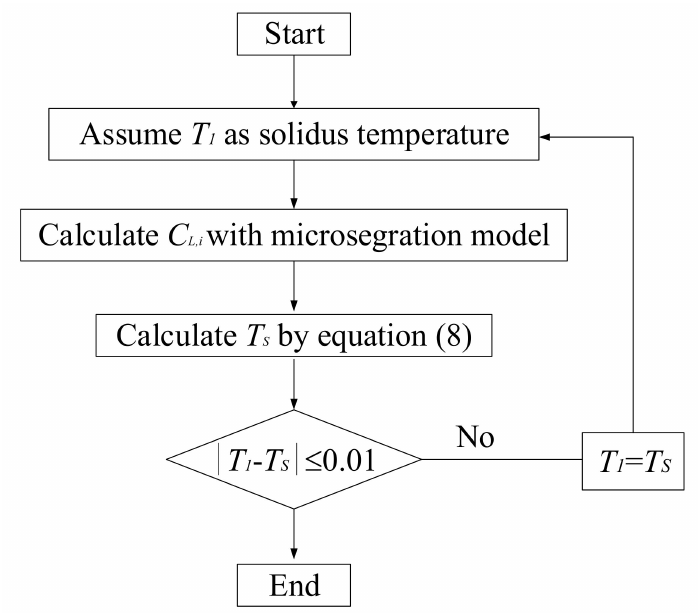
Figure 1. Flow chart for calculation of T S